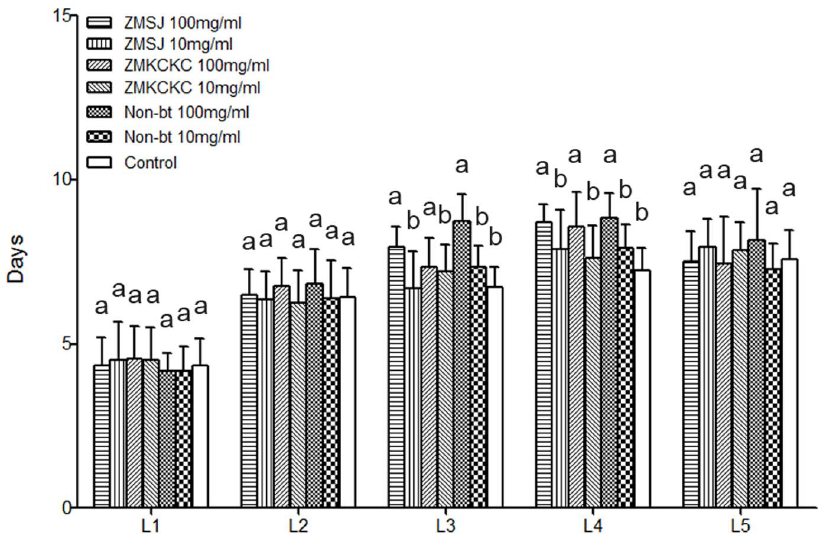
Figure 3. Duration of development of silkworm larvae treated with different doses of Bt pollen or non-Bt pollen. Values with the different letter are significantly different. Bars represent standard error. Levels of significance: P , 0.05 (followed by nonparametric tests-K independent samples: Kruskal-Wallis H-tests; two independent samples: Mann-Whitney U tests).